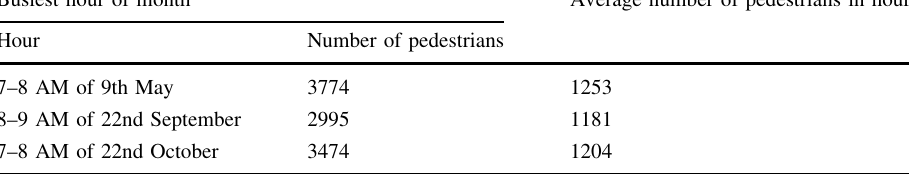
Table 1 Data obtained from